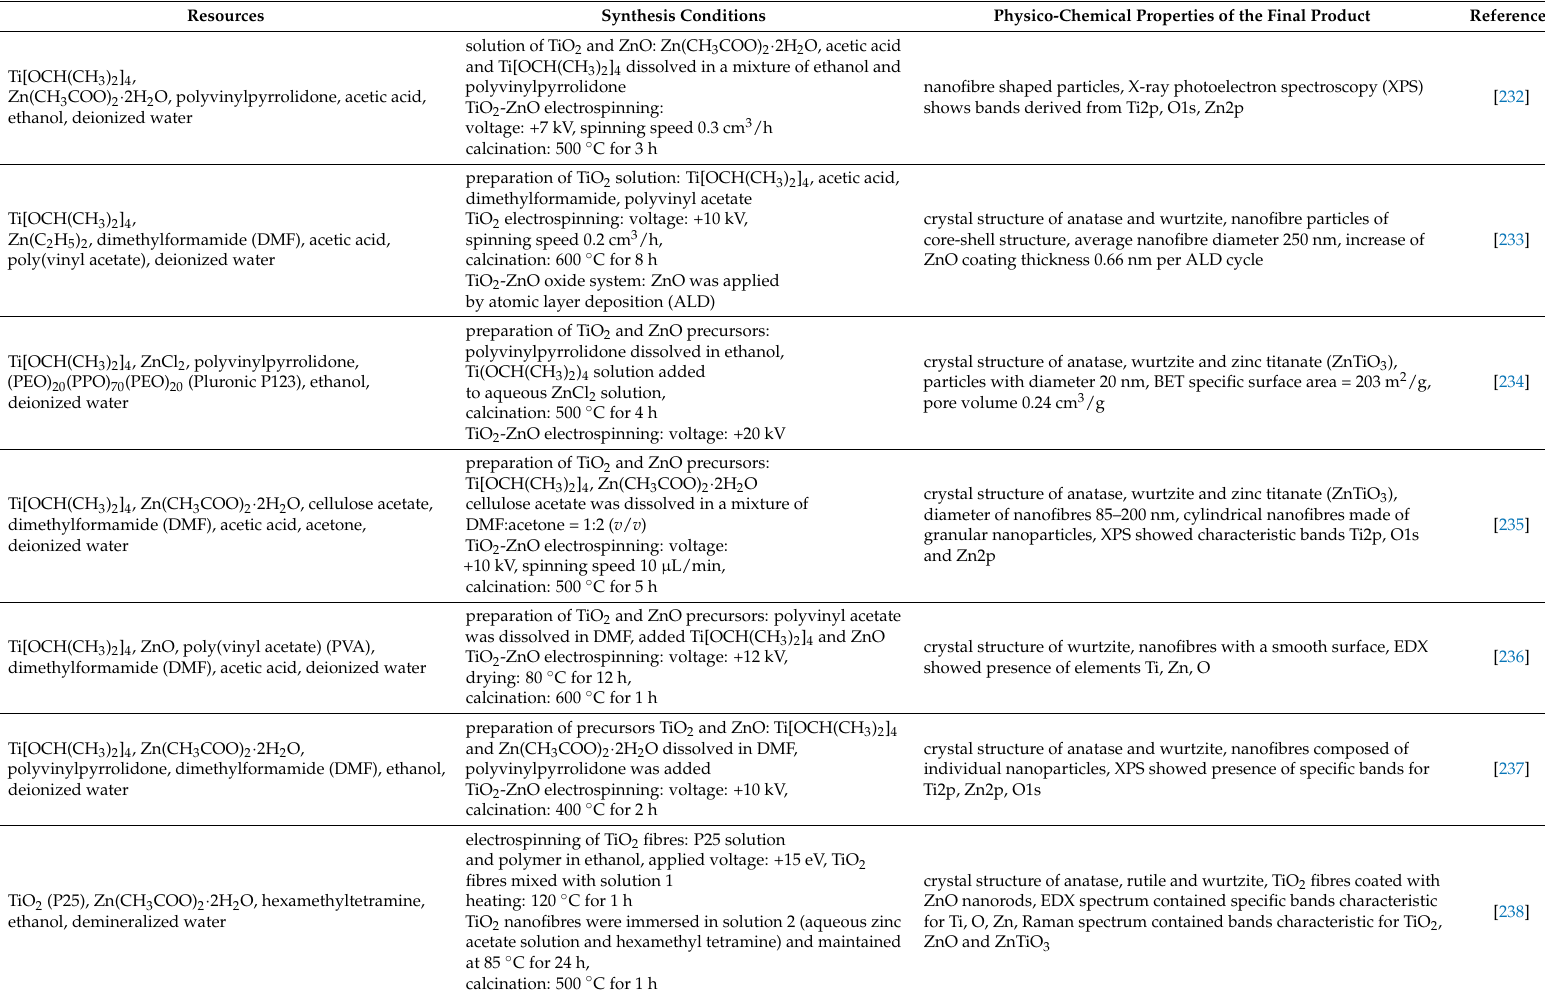
Table 7. Resources, synthesis conditions and physico-chemical properties of TiO 2 -ZnO hybrid systems obtained by the electrospinning